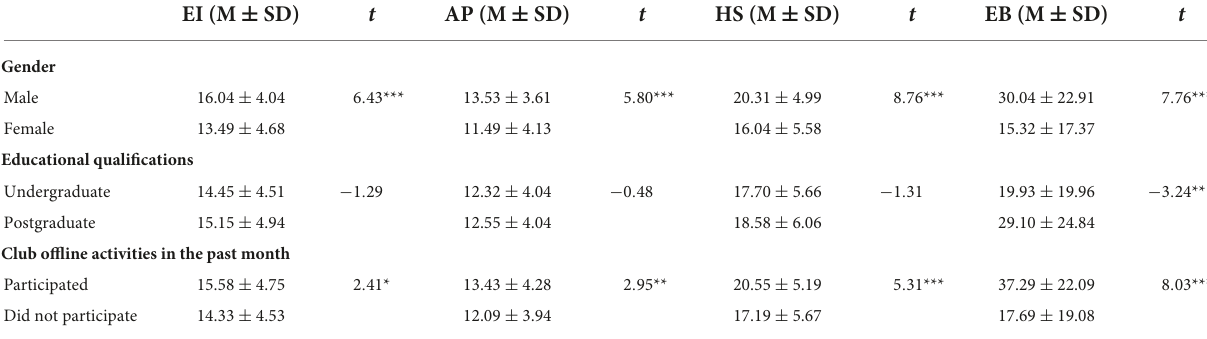
TABLE 2 Statistical differences in different categories of